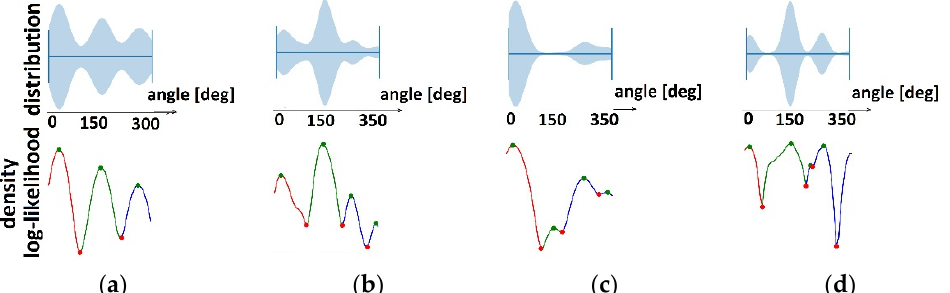
Figure 9. Clustering of temporal components (red dots are cluster limits) in patients for: ( a ) Paretic legs before therapy; ( b ) Nonparetic legs before therapy; ( c ) Paretic legs after therapy; ( d ) Nonparetic legs after therapy. Top graphics represent distribution densities, and bottom graphics represent bandwidth-smoothed distribution densities.